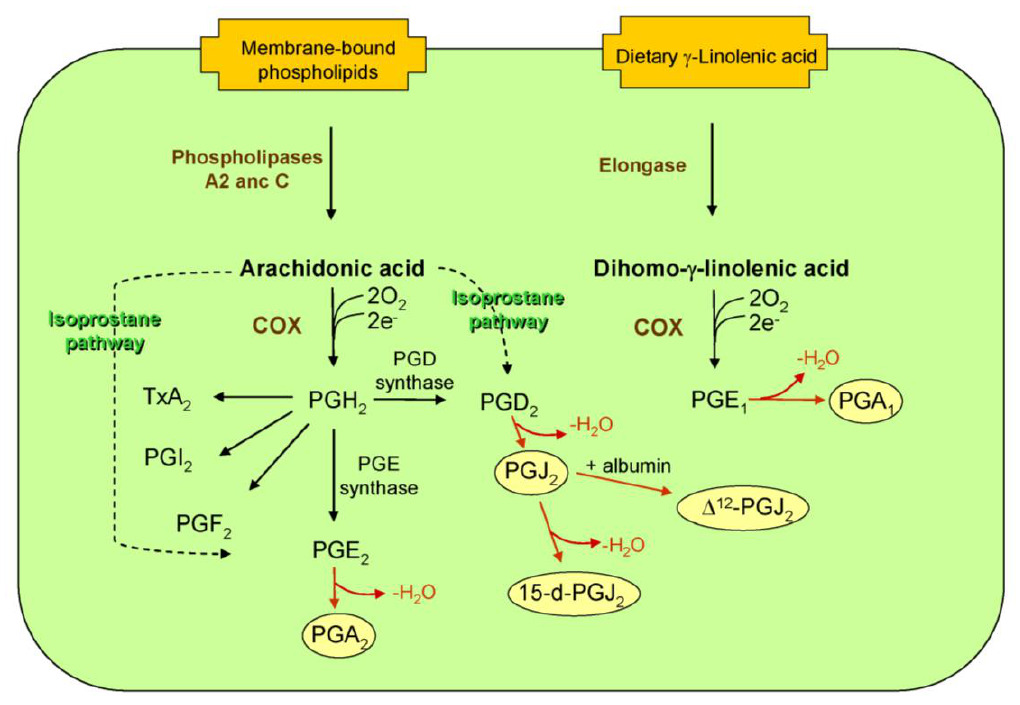
FIGURE 1. Pathways for the synthesis of prostanoids. COX enzymes acting on polyunsaturated fatty acids generate PG. The PG common precursor PGH 2 generated from arachidonic acid can subsequently be transformed by synthases into the various PG and TXA 2 . It should be taken into account that nonenzymatic transformation of polyunsaturated fatty acids can also give rise to PG through the isoprostane pathway. In addition, nonenzymatic dehydration of some PG leads to the formation of reactive cyPG (in yellow